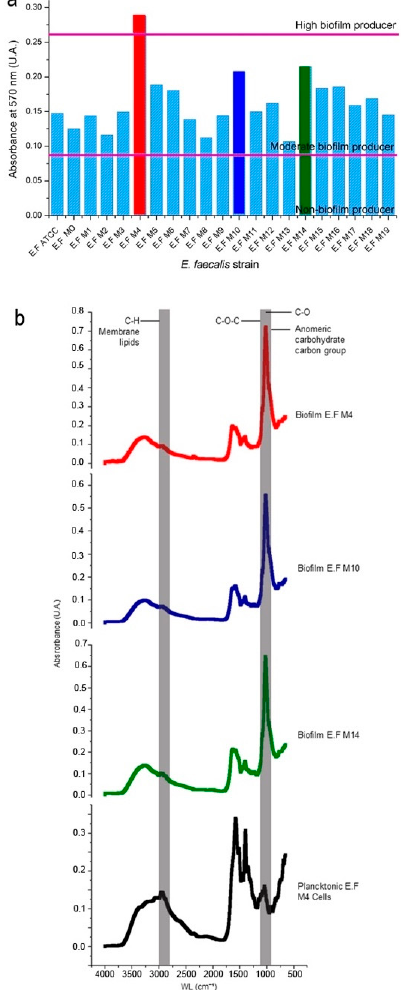
Figure 2. Biofilm production by E. faecalis strains and infrared spectra analysis of the biofilms produced by the selected strains. ( a ) Levels of biofilm production according to the absorbance recorded from the analysis of E. faecalis strains, the horizontal lines differentiating the three levels of production. ( b ) The characteristic bands of saccharides (gray areas) between 4000–800 cm − 1 are shown. The difference in vibrations between the spectra for biofilms and planktonic cells (non-biofilm production control) is evident mainly in the vibration bands of C-O, C-O-C, carbohydrate anomeric carbon, and C-H from membrane lipids. E.F ATCC, E. faecalis ATCC strain; E.F MD, E. faecalis isolated from a medical device (as a positive control for EPS production); E.F M1-19, E. faecalis clinical